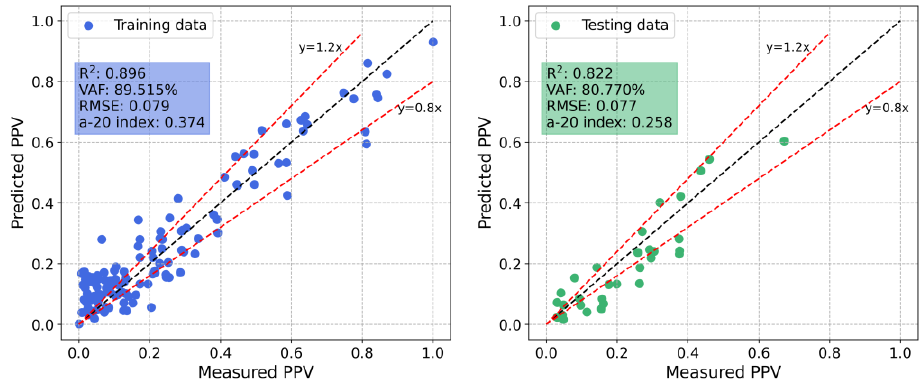
Figure 7. Predicted PPV values by the neuro-swam model VS measured ones.